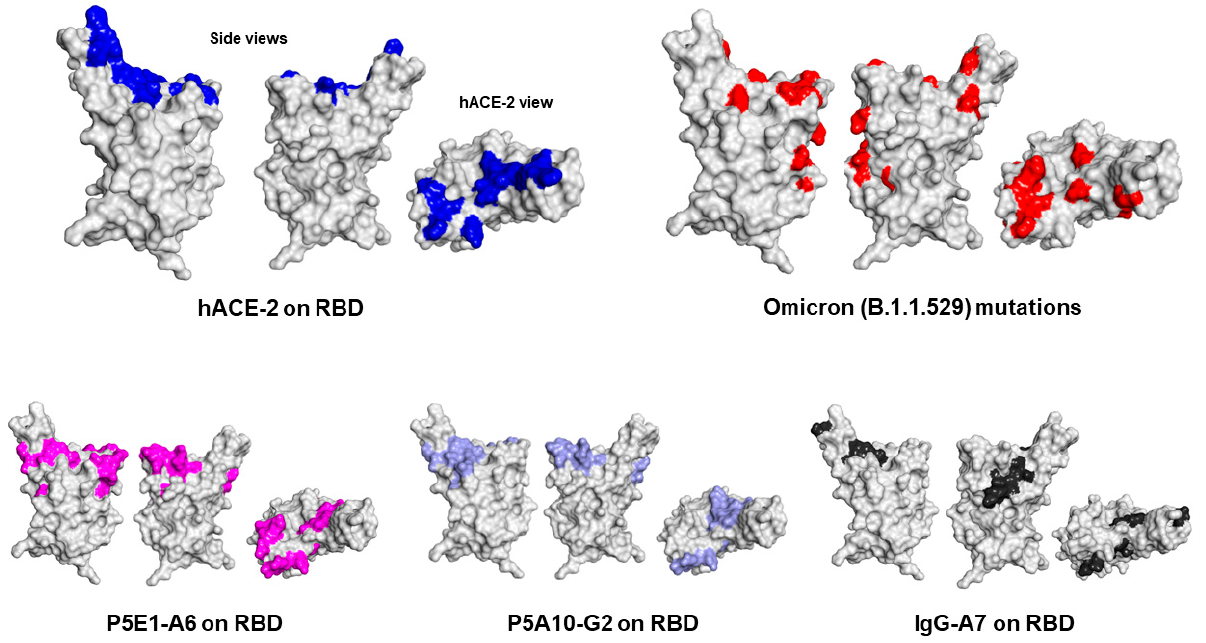
Figure 4. Epitope of P5E1-A6 (Violet), P5A10-G2 (light blue) and IgG-A7 (Black) on the Connolly surface of SARS-CoV-2 RBD WT. As a reference, we show, on the top left, two side views of the RBD rotated 180° and the top view of RBD interface (dark blue) with the hACE-2 (hACE-2 view). On the top right, Omicron mutations (red) with respect to Wuhan RBD. The figures were prepared with the PDB ID: 7SWP in Discovery Studio 2020 v20.1.0.19295 (BIOVIA)